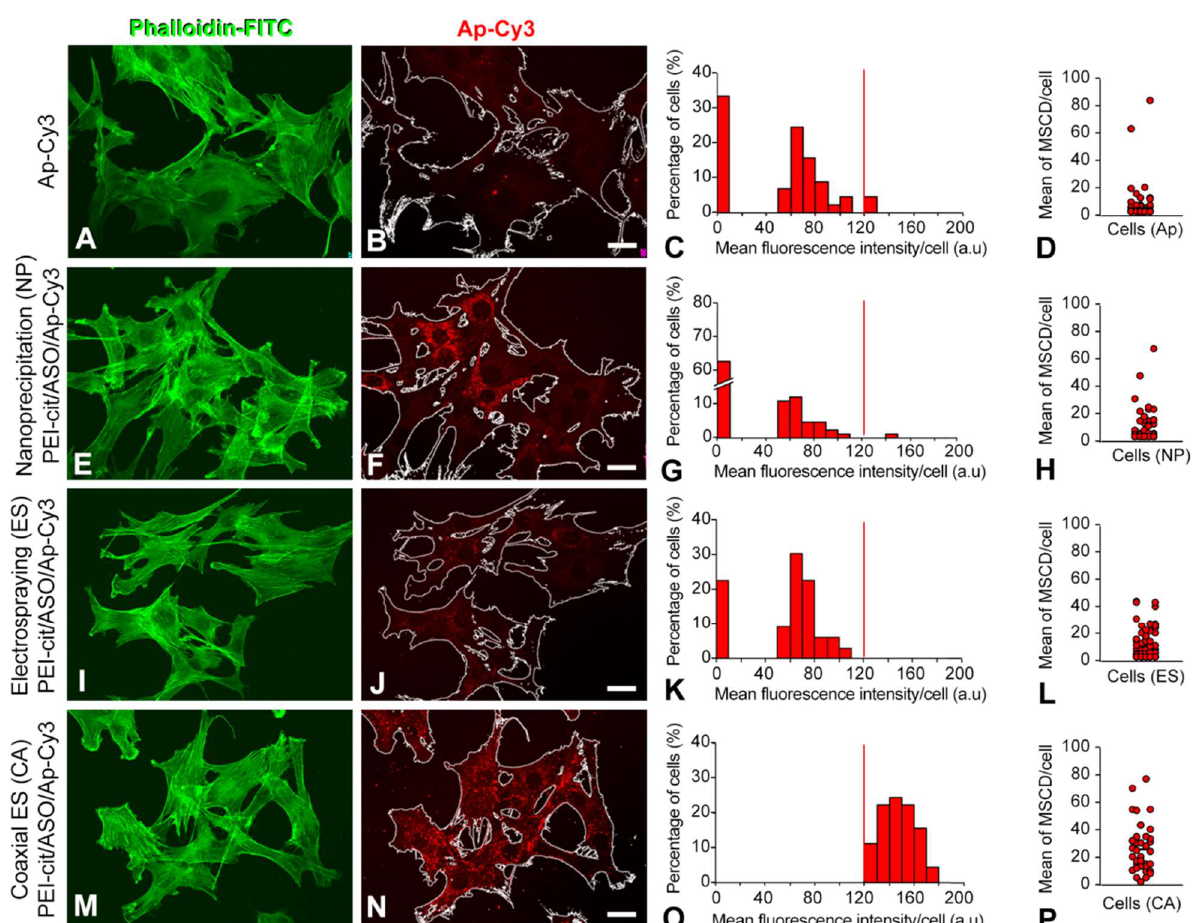
Figure 4. ( A , E , I , M ) Confocal images showing the actin filaments (FITC-conjugated phalloidin) of the cytoskeleton from C2C12 cells. ( B , F , J , N ) Analogous confocal images showing the same C2C12 cells outlined transfected with either free Cy3-conjugated aptamer ( B ) or with the PEI-cit/ASO/Ap- Cy3 nanocomplexes synthetized by nanoprecipitation (( E ), NP), electrospraying (( I ), ES), and coax- ial electrospraying (( N ), ES). ( C , G , K , O ) Mean fluorescence intensity histogram of the Cy3 aptamer signal only from nanocomplexes located at MSCD. Vertical red lines correspond to the threshold limit that discriminates the MFI corresponding to MSCD of areas above and below 0.5 μm 2 . ( D , H , L , P ) Dispersion diagram of the mean number of MSCD of mean area ≥0.5 μm 2 per cell. Note that most cells transfected with free aptamer ( D ), do not exhibit MSCD. Conversely, all cells trans- fected with CA nanocomplexes enclosed at least 1 MSCD in their cytoplasm. Scale bar: 20 μm.